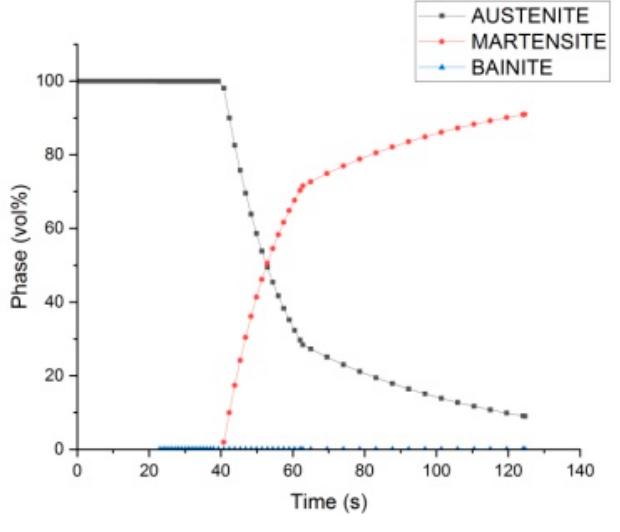
Figure 10. Phases changes with time.